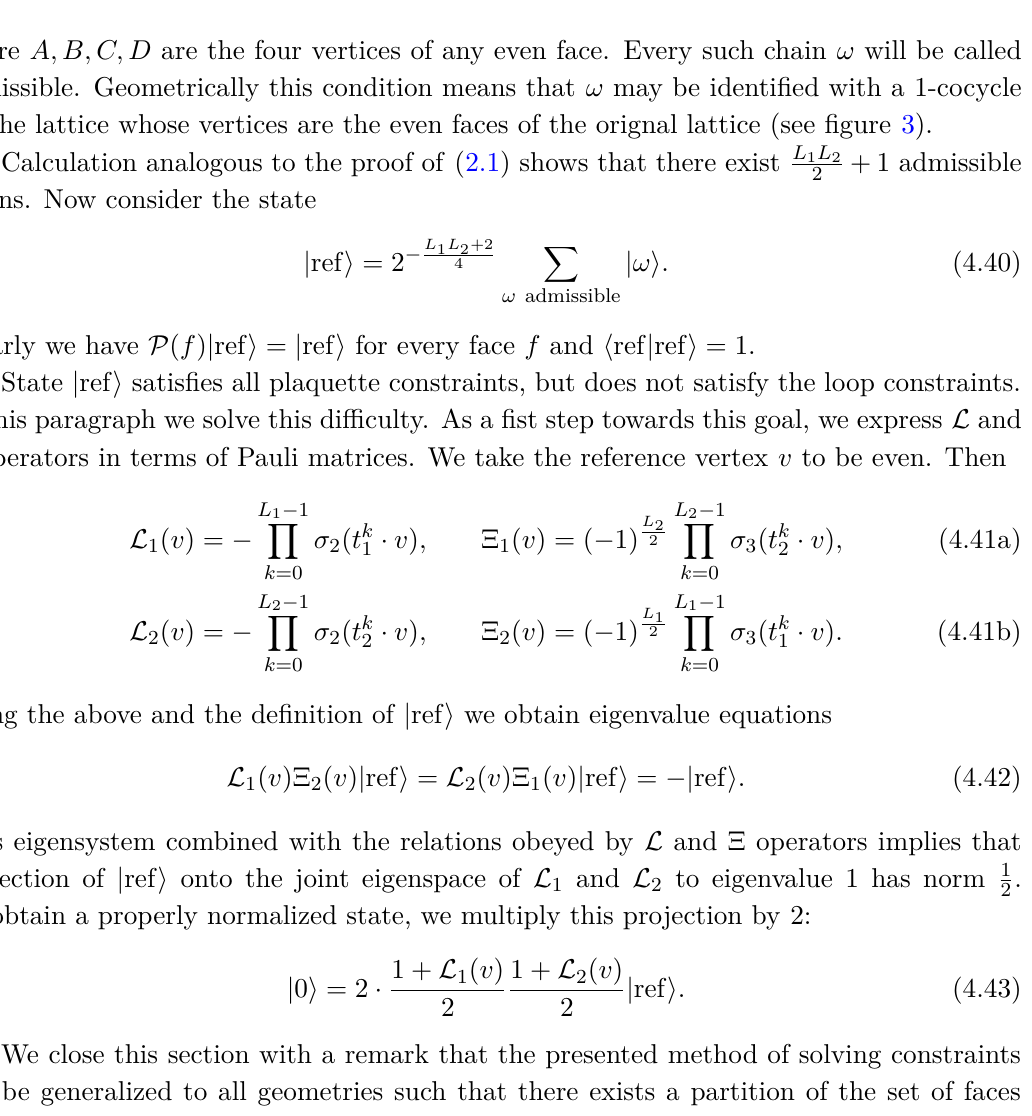
Figure 3 . Lattice whose vertices are the centres of even (shaded) faces of the original lattice. Its edges and faces correspond to vertices and odd (white) faces of the original lattice,